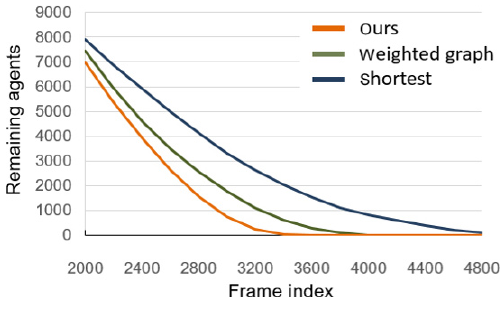
Fig. 8 Exhibition example. Unevacuated agents for the shortest path algorithm, the weighted graph algorithm, and our method. the right of the island, most agents can evacuate